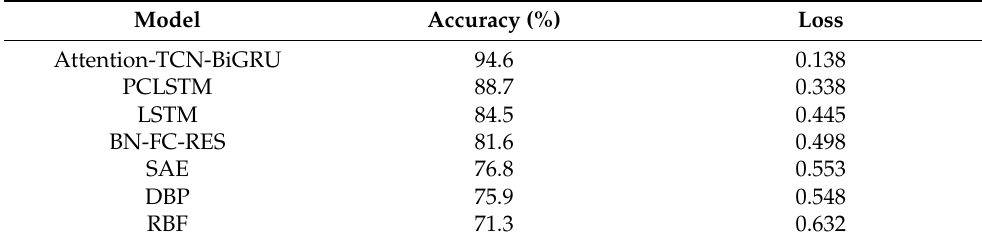
Table 10. Comparison of different intention recognition models.